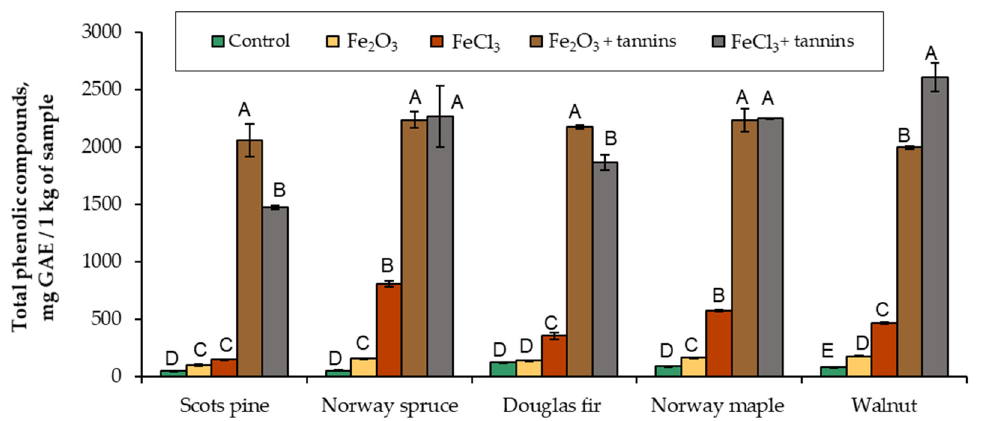
Figure 1. Content of total phenolic compounds (mg GAE—gallic acid equivalent/1 kg of the sample after processing) in the solvents after different treatments of different tree species. Bars show standard deviation of mean; different letters given above the bar show statistically significant differences between the treatments for each tree species at p < 0.05 ( n = 3).